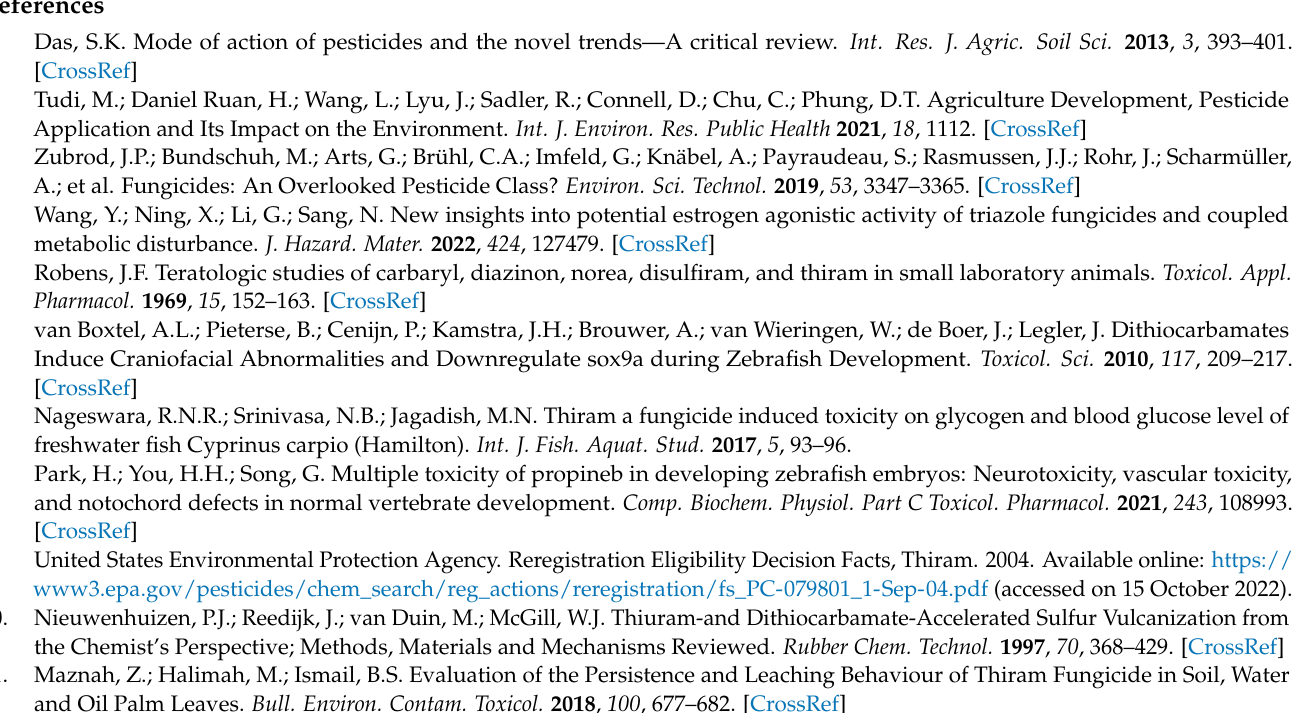
Figure S2: Numbers of up- and downregulated differentially expressed genes. Yellow bar, upregulated DEGs; blue bar, downregulated DEGs. Figure S3: List of enriched pathways in KEGG pathway enrichment analysis. Table S1: List of top upregulated (FC > 5) and top downregulated (FC < − 10) genes after 4.0 µ g/L thiram treatment. Table S2: List of primers used for qPCR. Supplementary file 1: Total list of DEGs obtained in high-dose (4.0 µ g/L) thiram-treated zebrafish (HTZF) (FC > 2 and FC < − 2). Video S1: video showing the heartbeats of DMSO-treated zebrafish embryos and 4.0 µ g/L thiram-treated zebrafish embryos. Videos were captured under a stereomicroscope (Stemi 508, Zeiss, Germany) at 96